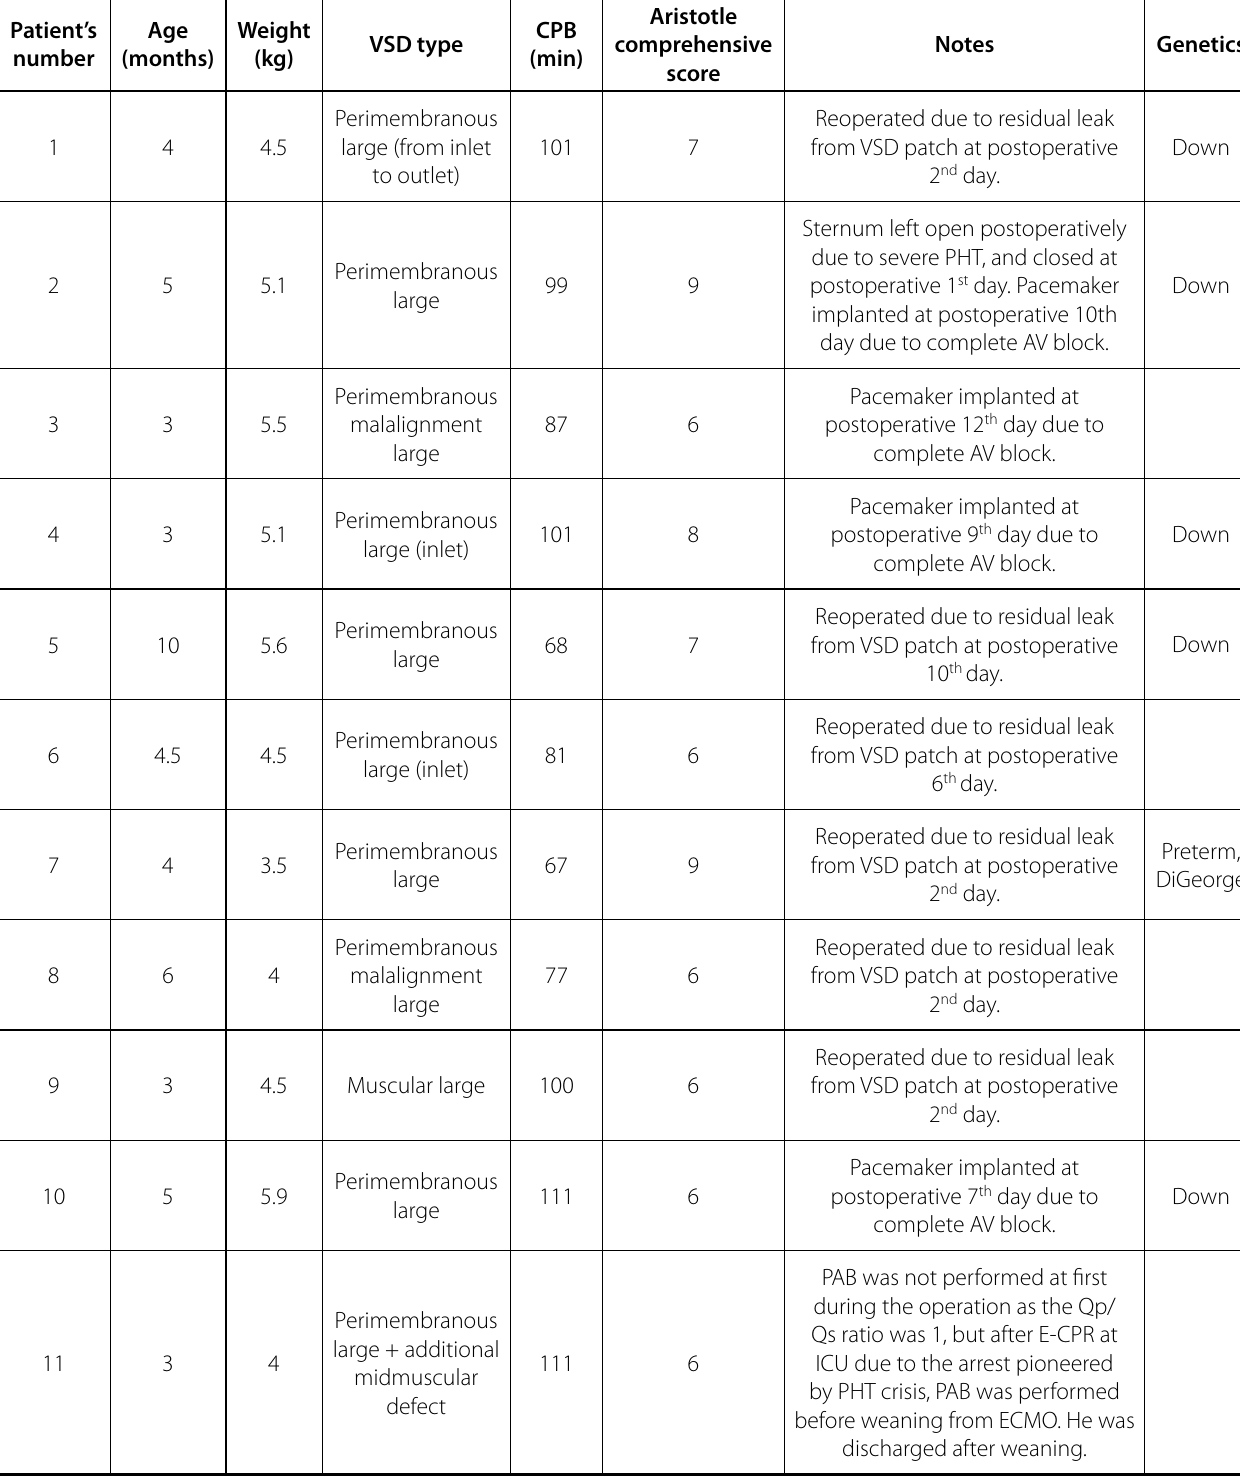
Table 5 . Major adverse events of 11 patients.